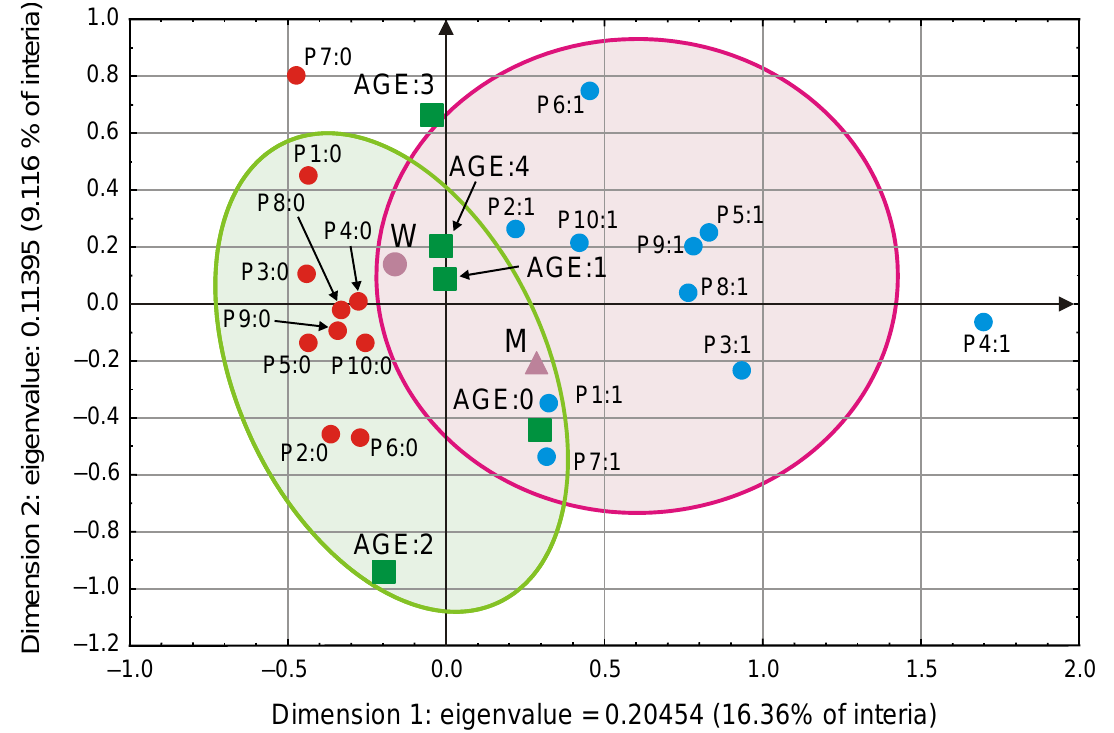
Figure 6. Two-dimensional plot of column coordinates—dimension 1 × 2. Input table (rows × columns): 27 × 27 Burt